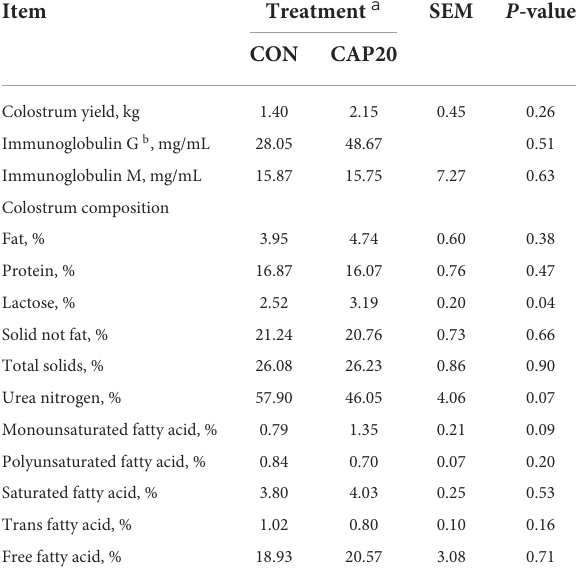
TABLE 2 Colostrum yield, immunoglobulin G (IgG), Immunoglobulin M (IgM), and colostrum composition data of buffaloes fed either 0 or 20 mg/kg dry matter of Capsicum oleoresin .